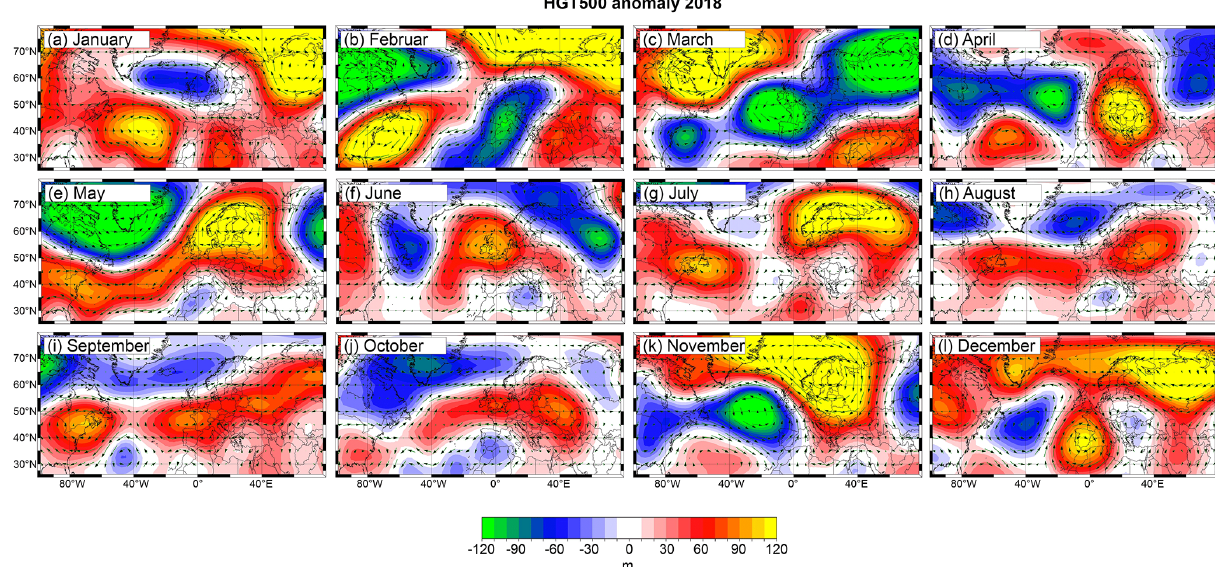
Figure A2. Monthly geopotential height at 500mbar (HGT500) anomalies throughout 2018 relative to the reference period (1971–2000).